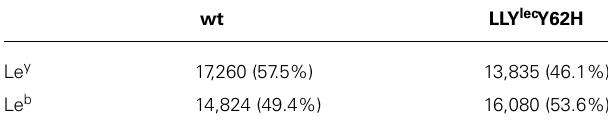
FIGURE 4 | LLY lec wt and LLY lec Y62H domains in complex with Lewis antigens. Comparison between (A) the LLY lec wt-Le y complex (orange carbons, greenTyr62) and (B) the LLY lec Y62H-Le y complex (purple carbons, green His62) shows that the water molecule shifts toward the histidine residue in LLY lec Y62H-Le y .The water-mediated hydrogen bond to the hydroxyl